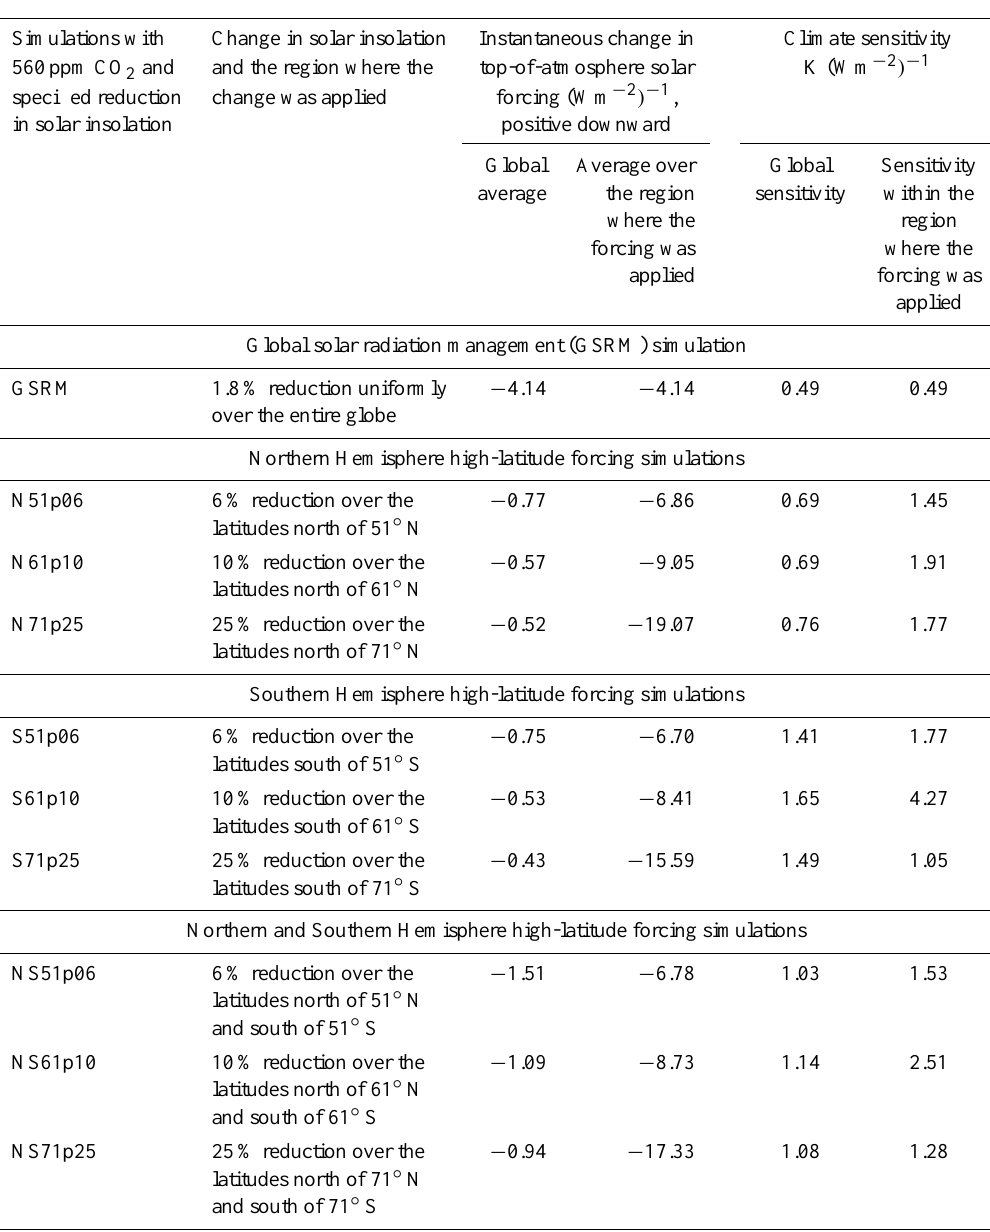
Table 1. Global and regional mean reductions in solar insolation and climate sensitivity for the various perturbation simulations. The baseline simulation with doubled CO 2 had a concentration of 560ppm and a solar constant of 1366Wm − 2 . Details of the calculations of climate sensitivity are described in Appendix